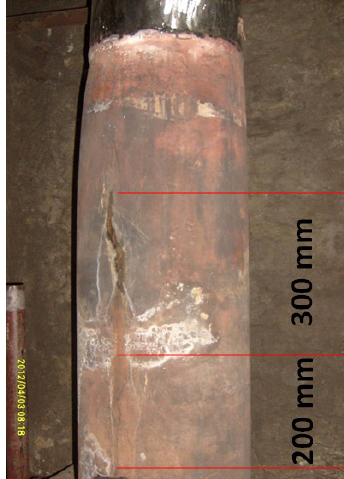
Figure 5: Determination of damage by visual inspection.